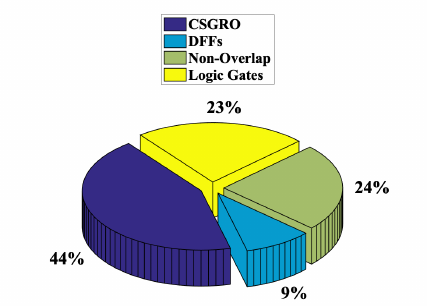
Figure 16. Power consumption breakdown associated to each